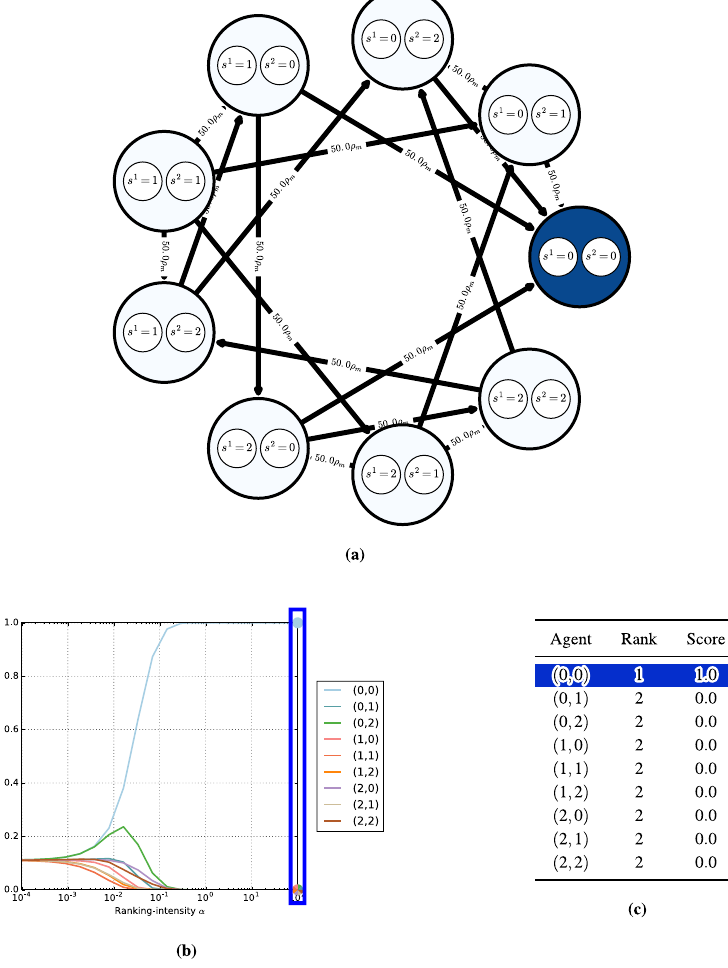
Figure 16. PSRO poker dataset. ( a ) Discrete-time dynamics (top 8 agents shown only). ( b ) Ranking-intensity sweep. ( c ) α -Rank strategy rankings and scores (top 8 agents shown